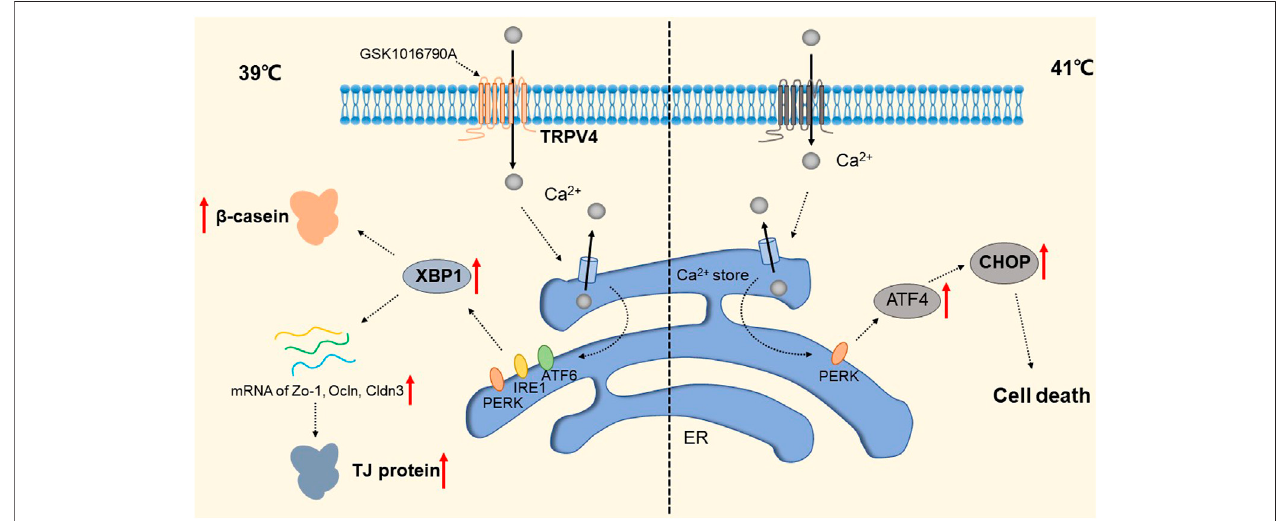
FIGURE 8 | Regulation of TRP Channels on breast cells at different temperatures. The activity of TRPV4 increased at 39 ° C. Activation of TRPPV4 by GSK1016790A leads to Ca 2+ in fl ux, promotes Ca 2+ release from the ER, and depletes Ca 2+ stores, at which point the UPR is initiated to upregulate transcript levels of Xbp1s via the PERK, IRE1, and ATF6 signaling pathways. This increased the expression of Zo-1, occln and Cldn3 mRNA and enhanced the expression of β -casein and TJ protein-coding genes. The presence of a certain TRP channel up-regulates the apoptosis transcription factor CHOP and promotes apoptosis through the UPR pathway at 41 ° C.